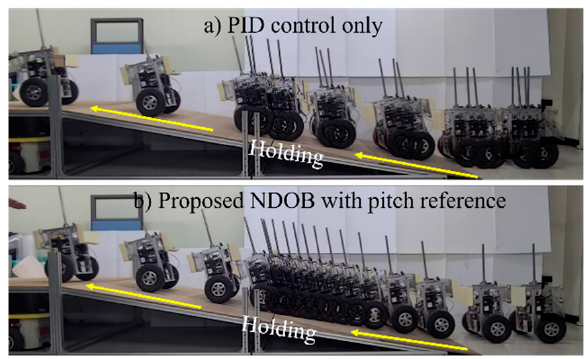
Figure 16. Holding a standstill position on the slope.